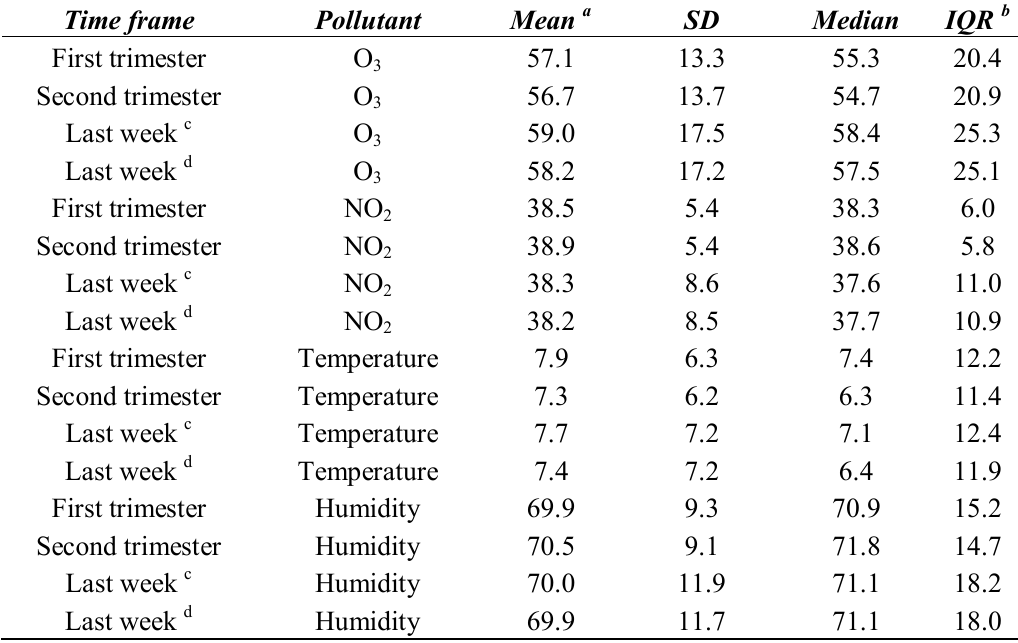
Table 1. Descriptive statistics of air pollutants and meteorological